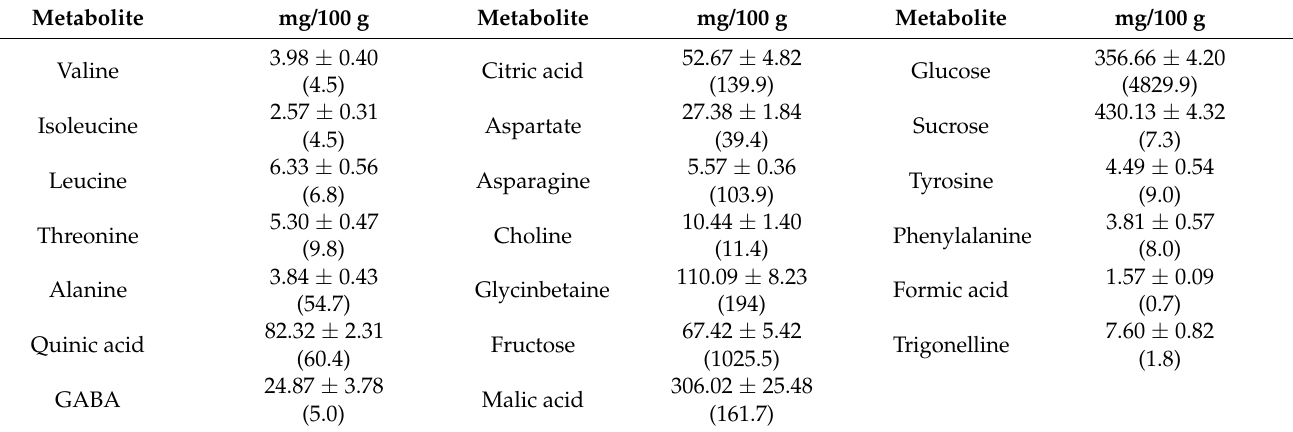
Table 5. Compounds identified and quantified in the 1 H NMR spectrum of the Bligh-Dyer hydroalcoholic extracts of BL1 Goji leaves. In brackets, the value obtained in the correspondent berries sample for each metabolite was also reported for comparison. Results were expressed as mg/100 g of fresh sample ± SD.